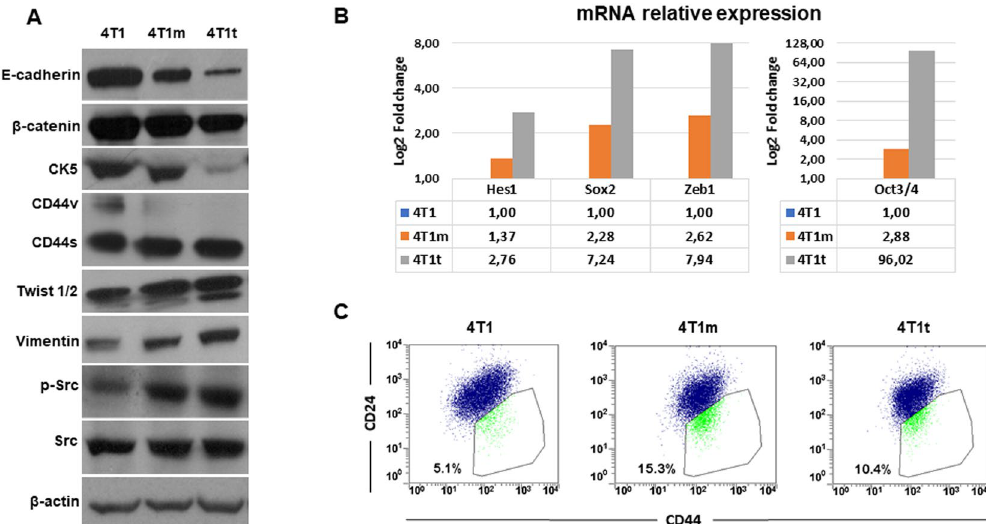
Figure 3. 4T1 cells transplanted in vivo undergo a partial EMT and acquire stem-like cell characteristics. ( A ) Western blot analysis of EMT protein markers and Src. Active Src (p-Src) was detected with a mAb specifically recognizing Src phosphorylated on Y418. β -actin was used as a control for protein loading. The blot shown is representative of two independent experiments. ( B ) Analysis of mRNA expression of the indicated transcription factors. Normalized transcript levels were measured by real-time qRT-PCR relative to hprt mRNA levels. Values (mean of duplicate determinations) represent increases with respect to 4T1 parental cells, which were given an arbitrary value of 1. ( C ) Flow cytometry analysis of the cell-surface markers CD44 and CD24 in the indicated cell lines. The percentage of CD44 high /CD24 med/low cell subpopulation is indicated. A representative experiment out of two is